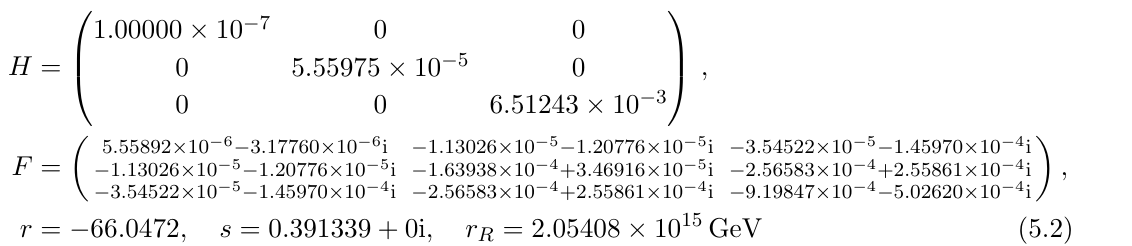
Table 2 . Values of the (cid:31) 2 function for the six di(cid:11)erent cases considered. for \Type-I+II"